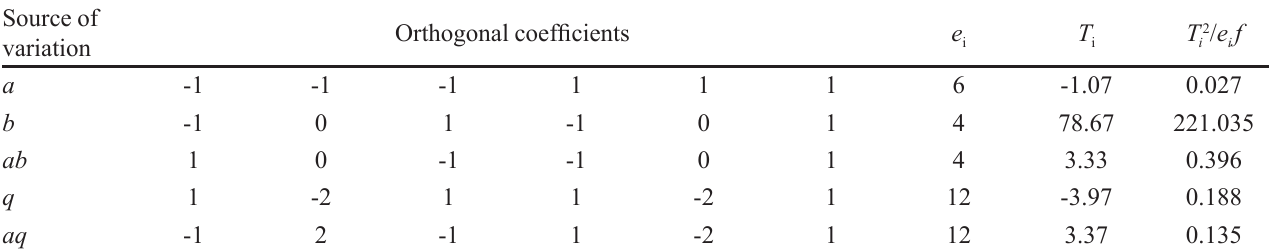
TABLE VII - Coefficients and orthogonal contrasts for the ofloxacin microbiological assay, according to the International